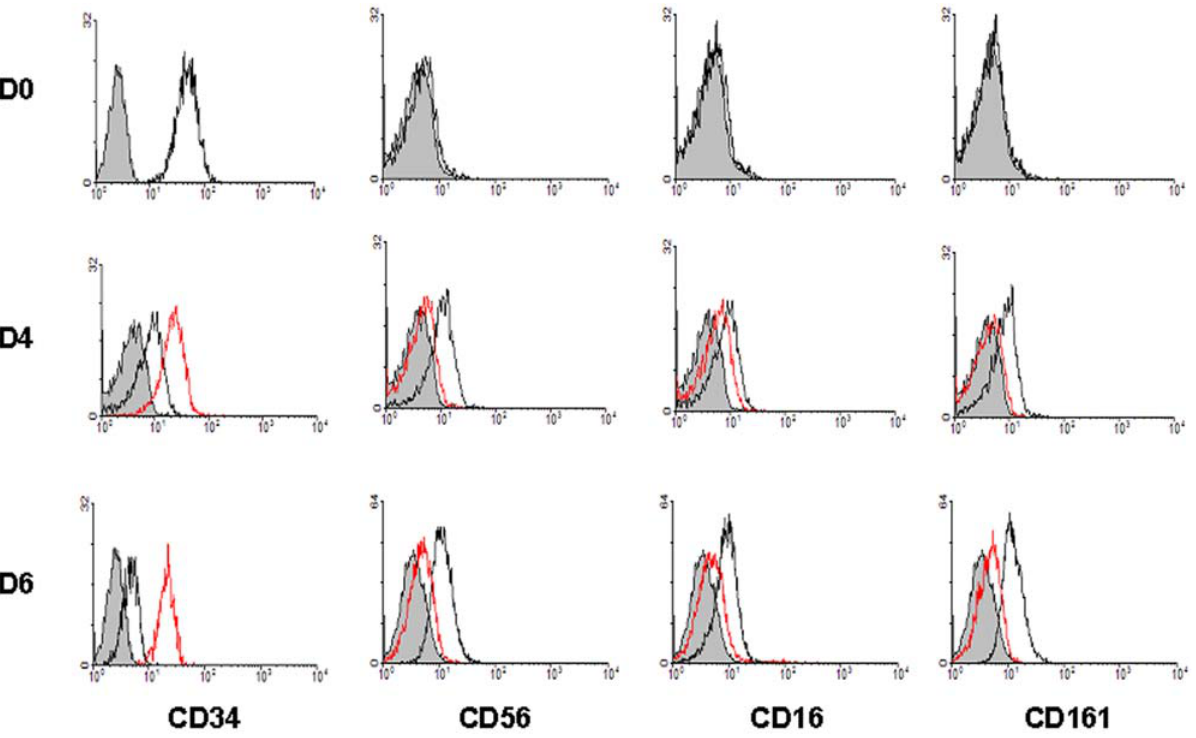
Figure 5. Interference on mb-IL-15 functions causes the down-regulation of NK markers. To test the hypothesis that PB-HP could be committed into the NK pathway under the control of the endogenous mb-IL-15, IL-15 trans -presentation was blocked adding neutralizing IL-15R a (continuous red line) mAbs at the first and at the fourth day of the cell culture. Blocking IL-15R a chain causes the inhibition of CD56, CD16 and CD161 expression (D4-D6), while the treatment preserves the initial level of CD34 expression (D4-D6). NK markers expression (continuous black lines). Isotype controls (shadowed peaks).